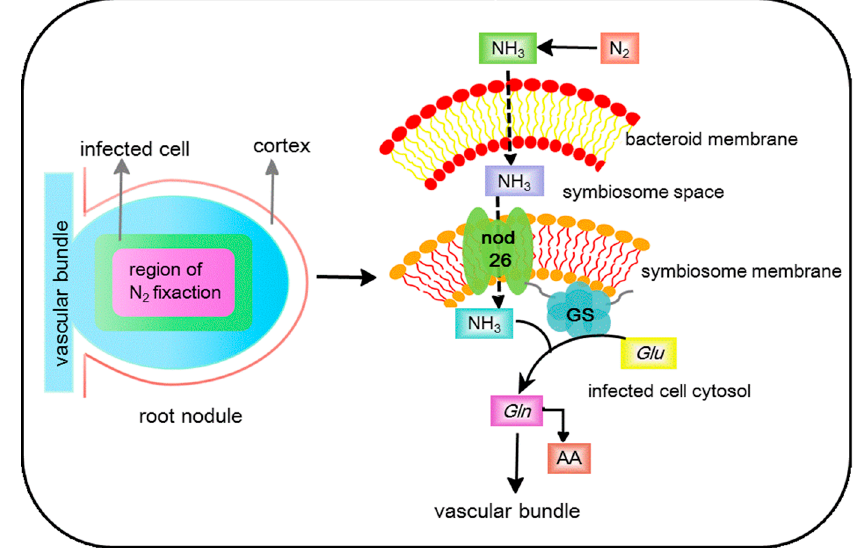
Figure 1. Root nodules showing regions of active nitrogen fixation, and a model of nitrogen efflux and assimilation with the interaction of nodulin 26/glutamine synthetase (GS). Fixed nitrogen within the symbiosome space can be transported by the nodulin 26. GS which bind to the C-terminal domain of nodulin 26 serves as a site in the symbiosome membrane for rapid assimilation ammonia, and then gets released into the infected cell’s cytosol. GS, glutamine synthetase; Glu, glutamate; Gln, glutamine; AA, amino acid.